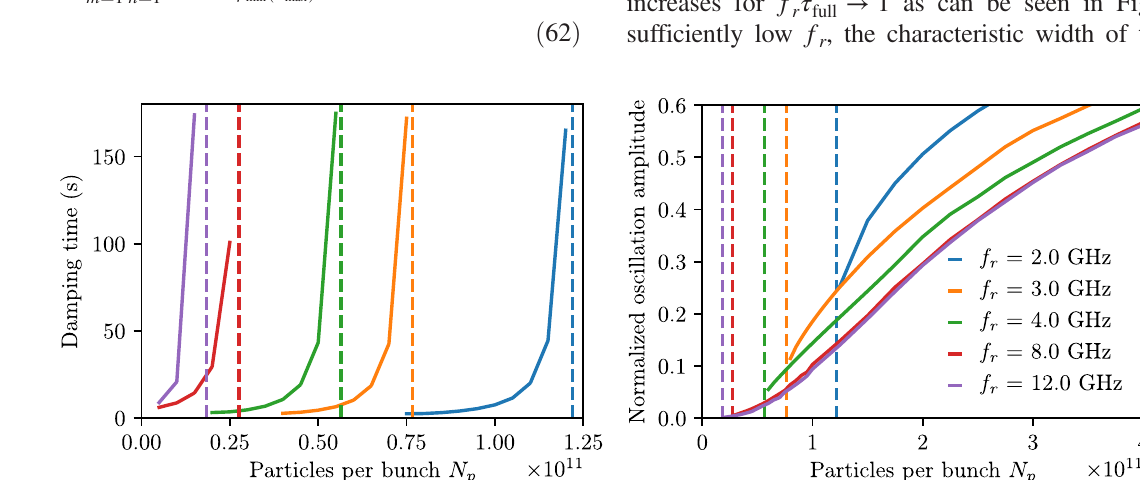
FIG. 10. The damping time below the LLD threshold (left) and the residual oscillation amplitudes normalized to the initial kick above the LLD threshold (right) versus bunch intensity for different resonator frequencies f Dashed vertical lines indicate the corresponding LLD thresholds calculated with MELODY